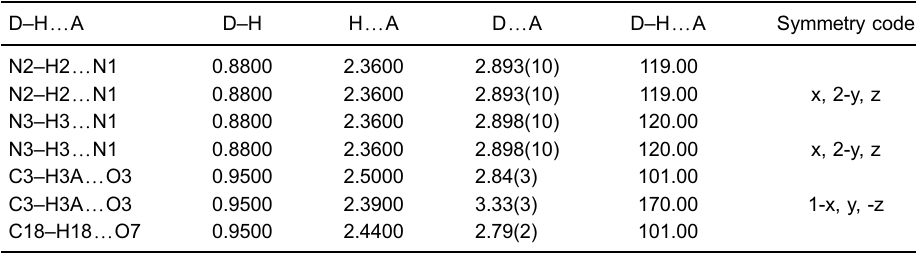
Table 2. Hydrogen bonds information (Angstrom, Deg).